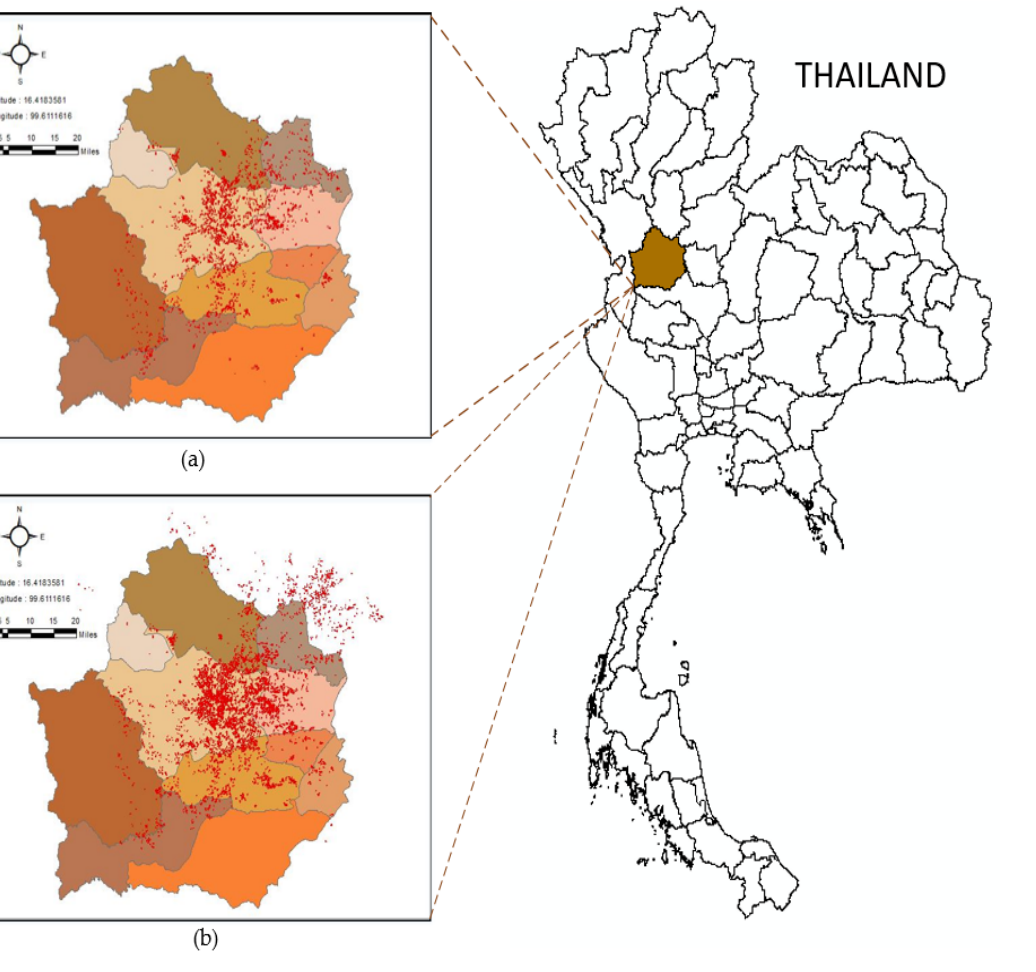
Figure 4. Silhouette of Kamphaeng Phet Province and its subdistricts, with red dots indicating the location of sugar cane fields surveyed by local sugar mills: ( a ) 2018–2019 and ( b )